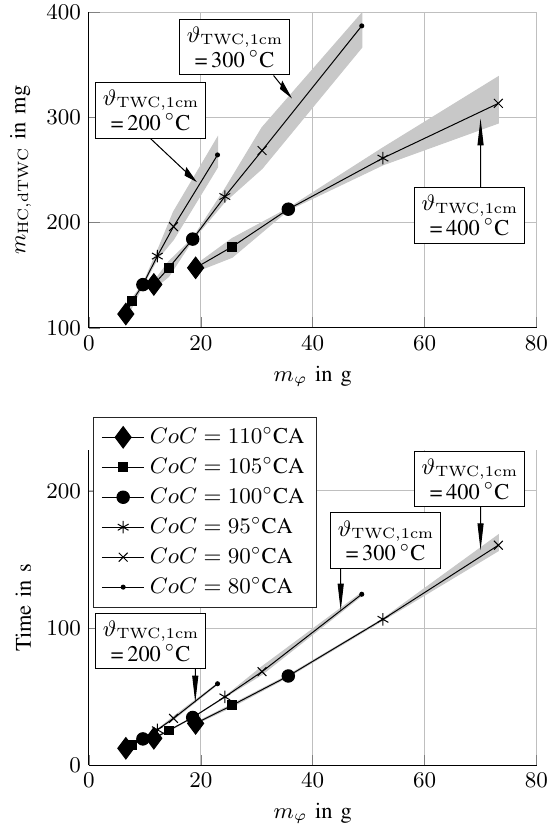
Figure 10. Cumulative tailpipe hydrocarbon emissions, total fuel consumption, and the time required until a certain temperature in the three-way catalytic converter (TWC) is reached. Five different fixed centers of combustion are compared; for each, three experiments are recorded. The gray areas are bounded by the maximum and minimum measured data samples, while the lines represent the average trends. With a set point of CoC = 80 ◦ CAATDC, ϑ TWC,1cm = 400 ◦ C cannot be reached within the 200 s